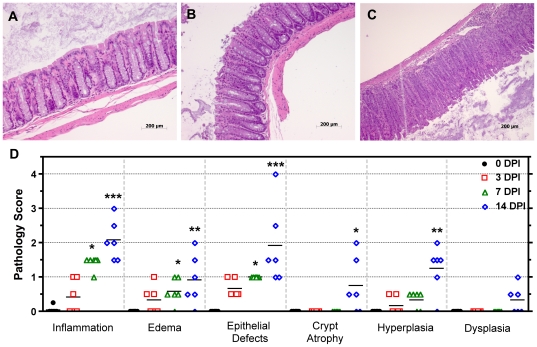

C. rodentium-induced colonic effects in C57BL/6 mice.(A) Mock inoculated animals at 0 DPI with normal colonic architecture where epithelial integrity and goblet cells appear intact. (B) Colon at 3 DPI showing epithelial defects at the top of the crypt. (C) Colon at 14 DPI demonstrating hyperplastic crypts and depletion of goblet cells. (D) C. rodentium induced statistically significant histological changes as early as 7 DPI (inflammation, edema, epithelial defects) in colonic sections and found to be most dramatic at 14 DPI. Crypt atrophy and minimal dysplastic changes were only noticeable at 14 DPI. Changes in inflammation, edema, epithelial defects, and hyperplasia as early as 3 DPI were noted, but failed to reach statistical significance (Kruskal-Wallis non-parametric test with Dunn's multiple comparison test: * P<0.05, ** P<0.01, *** P<0.001). Symbols indicate individual animals and lines indicate group means.